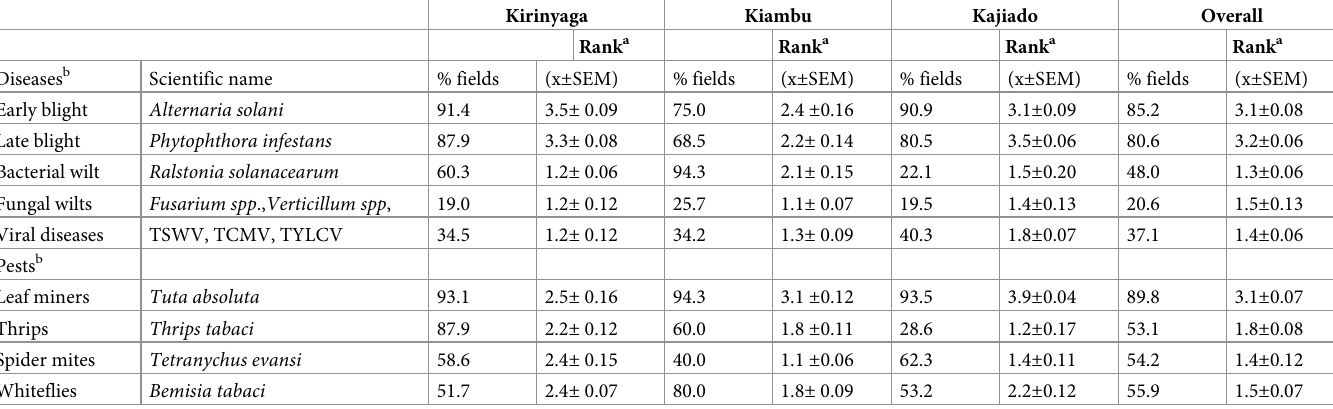
Table 3. Prevalence and farmer’s ranking of major biotic constraints to tomato